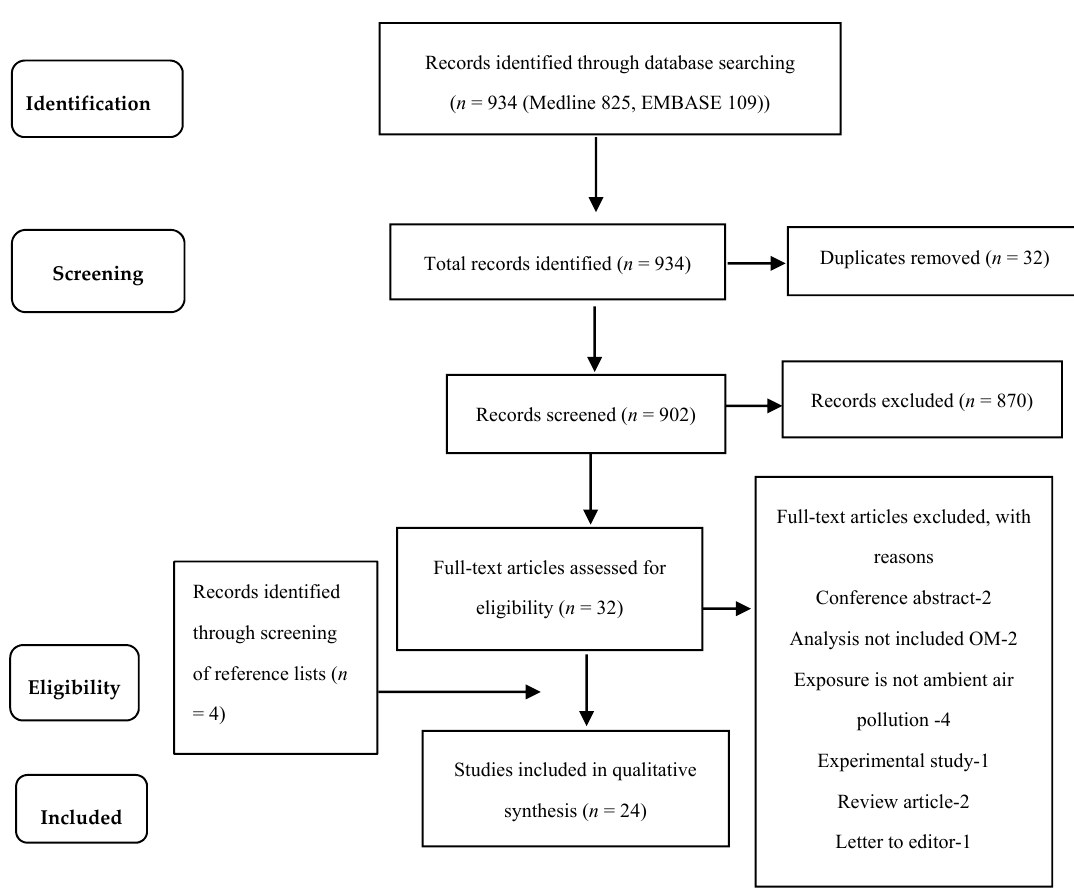
Figure 1. The PRISMA flow diagram for selection of studies for the review. (NOTE: “Records” include a mixture of full journal articles of original research, published abstracts, protocols, invited commentaries, and reviews).